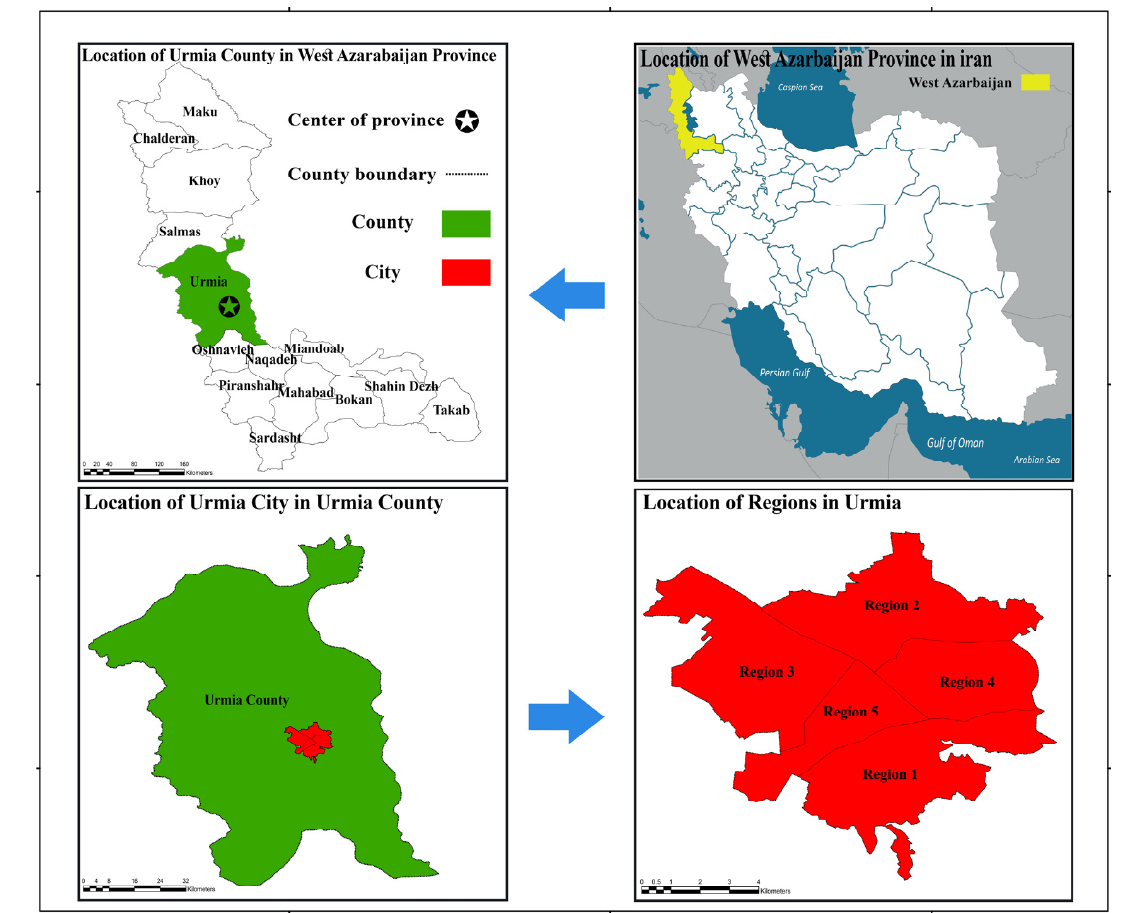
Figure 2. Spatial Structure of case study. [53,54].